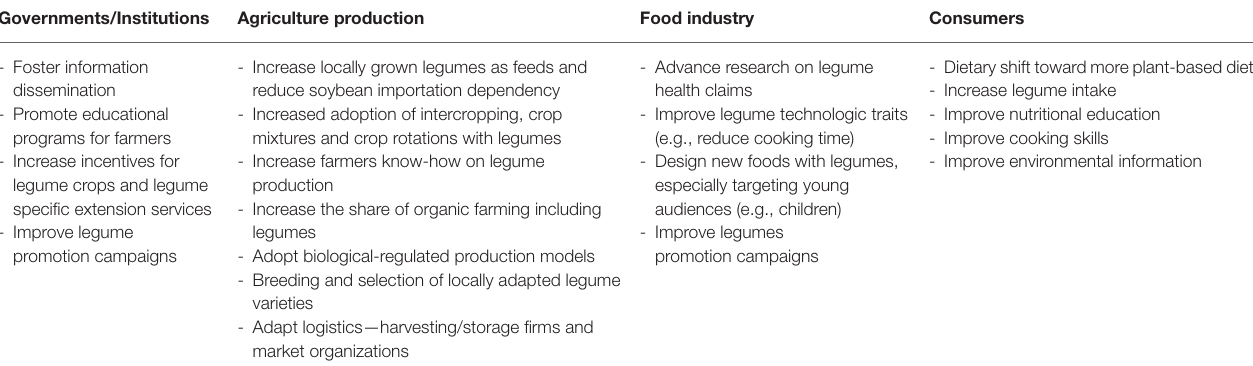
TABLE 1 | Summary of main actions to promote legumes within sustainable agri-food systems.